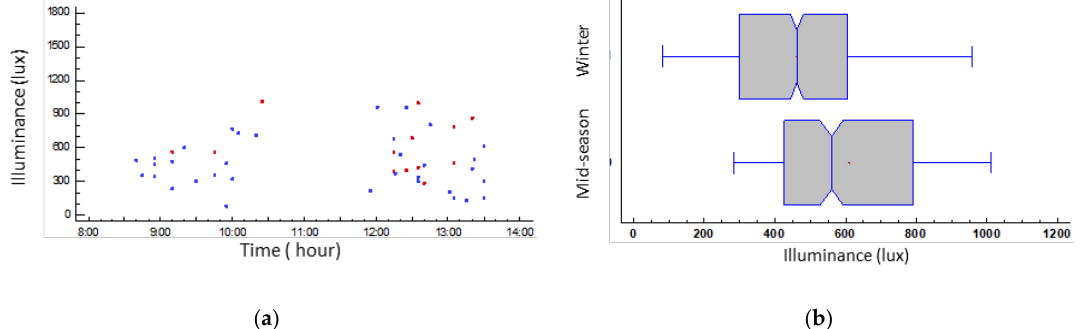
Figure 7. Room illuminance. ( a ) Hourly distribution for mean-room illuminance by season: winter (blue) and middle-season (red). ( b ) Quartile distribution of mean-room-illuminance by season (top) winter (down) mid-season.